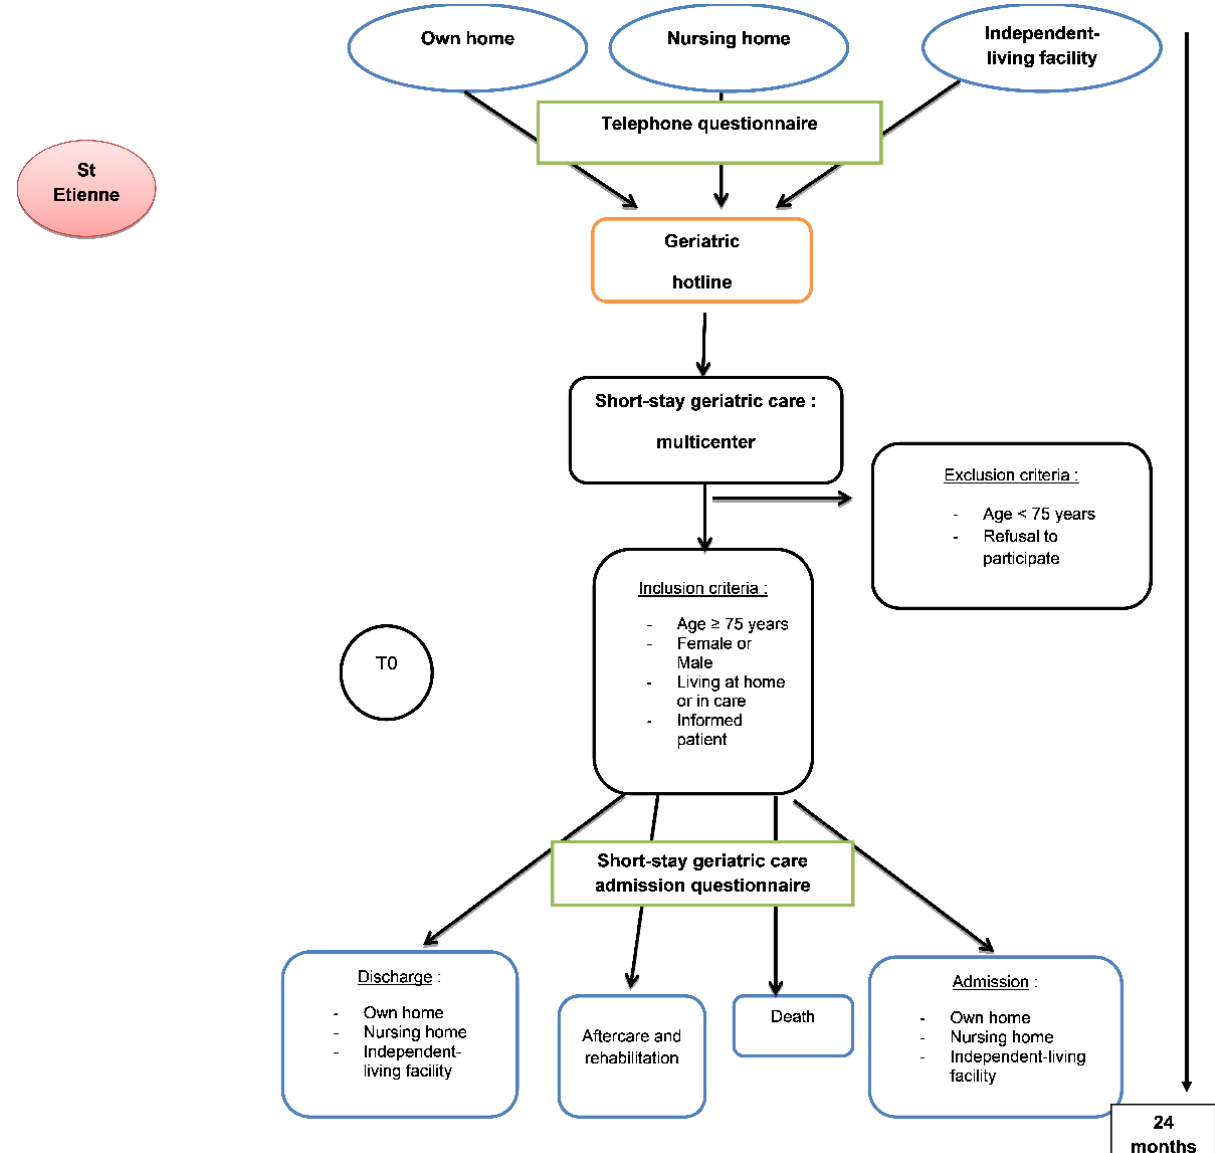
Figure 1. Flowchart of the study